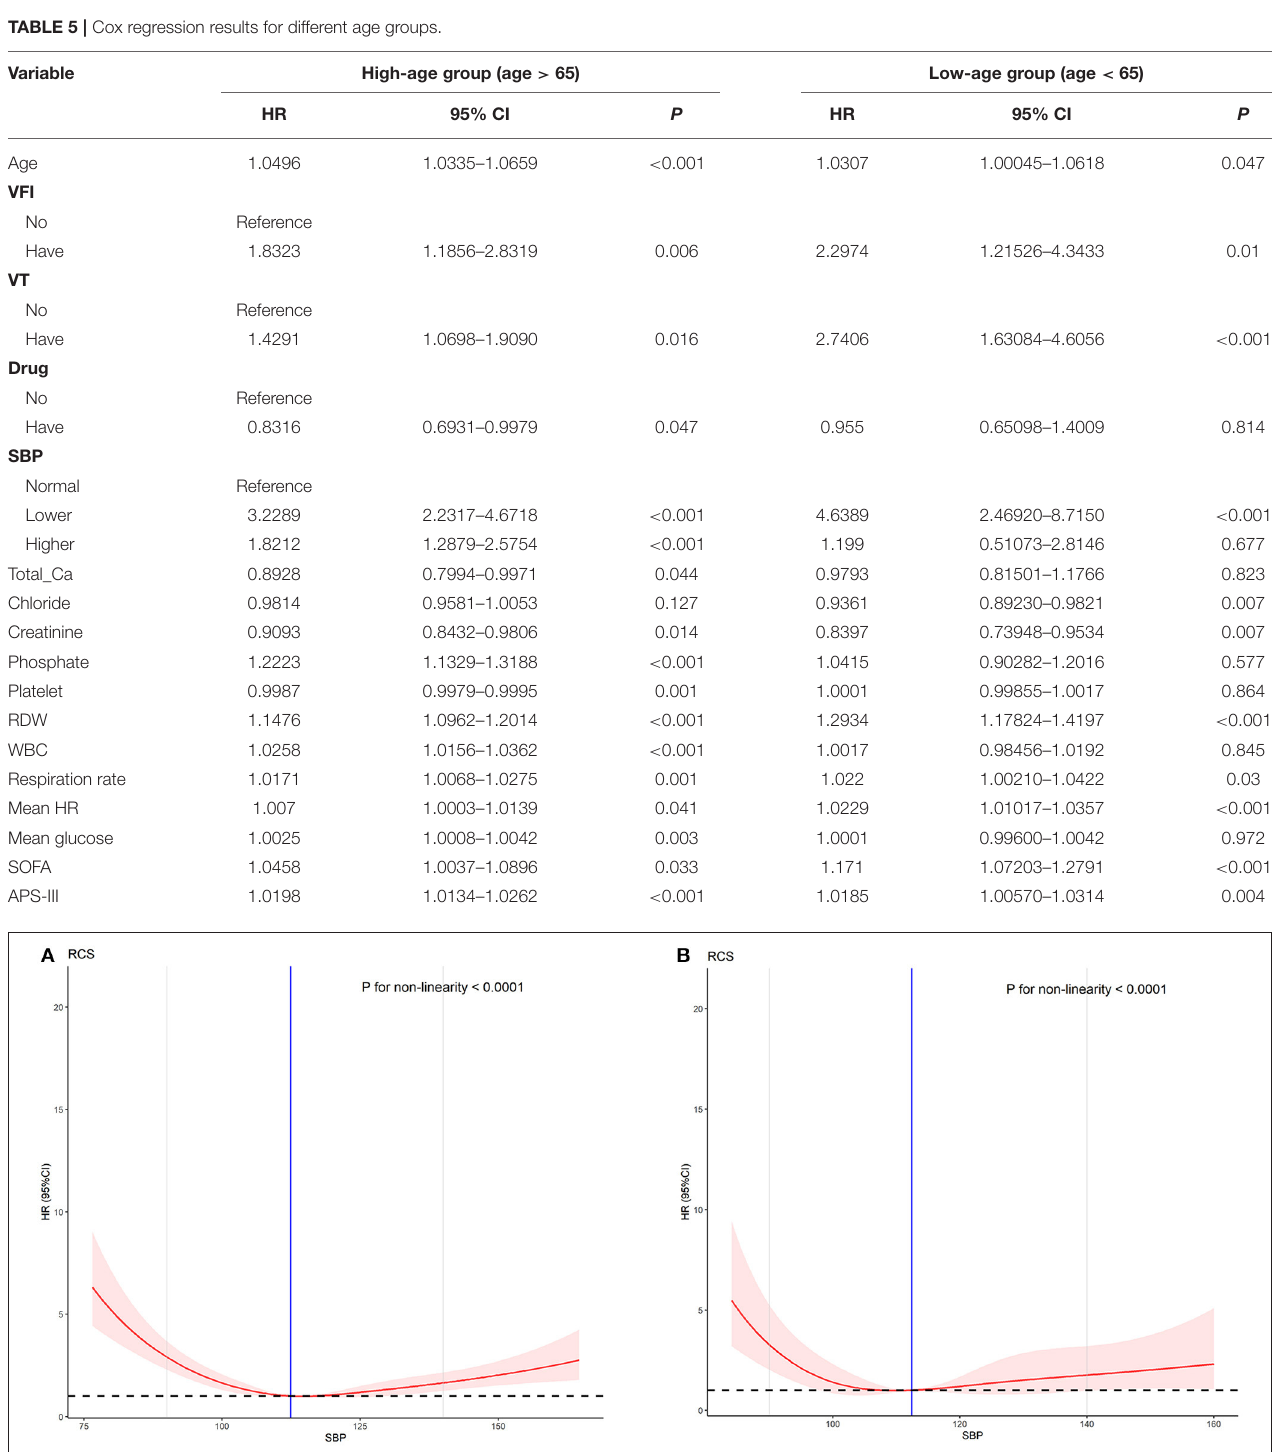
in the RCS analysis is non-linear, and the non-linear test is statistically significant ( P < 0.001). Moreover, in the sensitivity analysis, all models with low SBP had higher risks than those